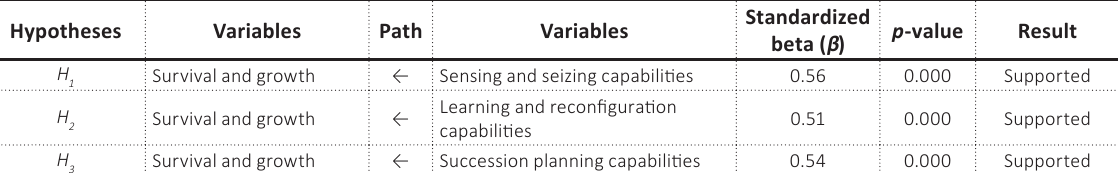
Table 3. Hypotheses test